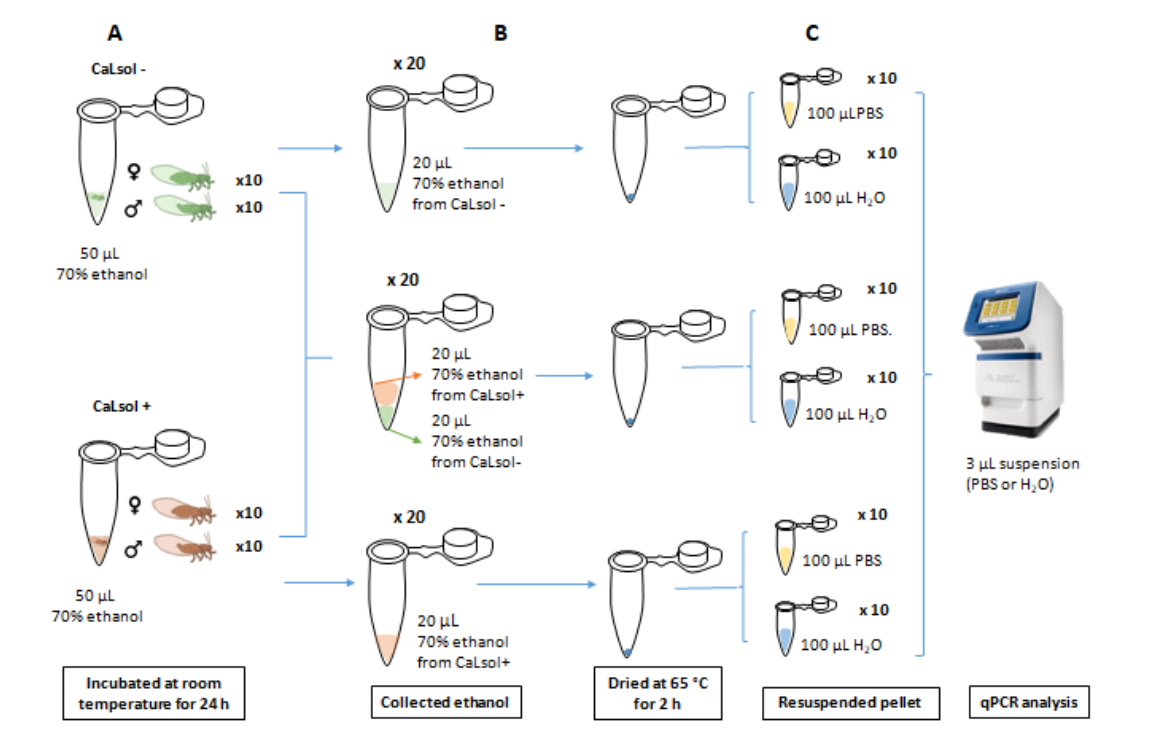
Figure 1. Cross-contamination study: Assay 1. CaLsol-positive and CaLsol-negative psyllids were individually incubated in Eppendorf tubes with 70% ethanol ( A ). Aliquots of ethanol were individually transferred to tubes or by mixing aliquots of positive and negative samples prior to drying ( B ). The samples were resuspended in water or PBS before direct qPCR analysis ( C ). ♀: female; ♂: male.